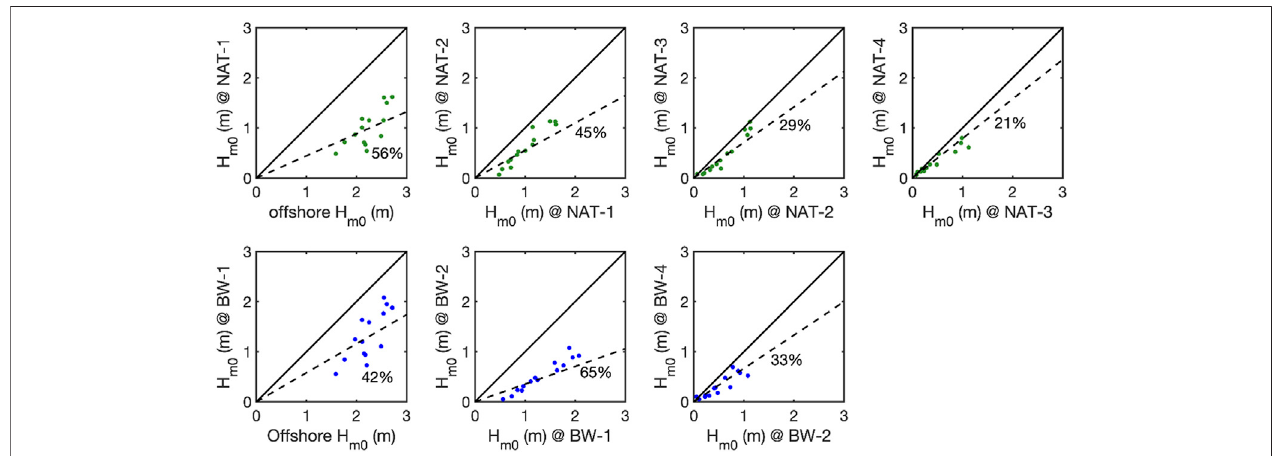
FIGURE 5 | Comparison of measured zero-moment wave heights at neighboring wave gauges along the two transects.